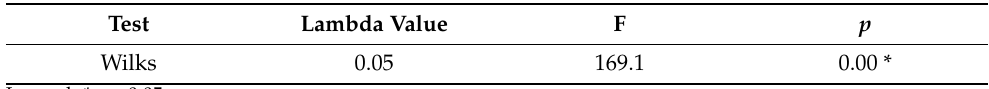
Table 1. Results of MANOVA for short turns executed in IS and AS.